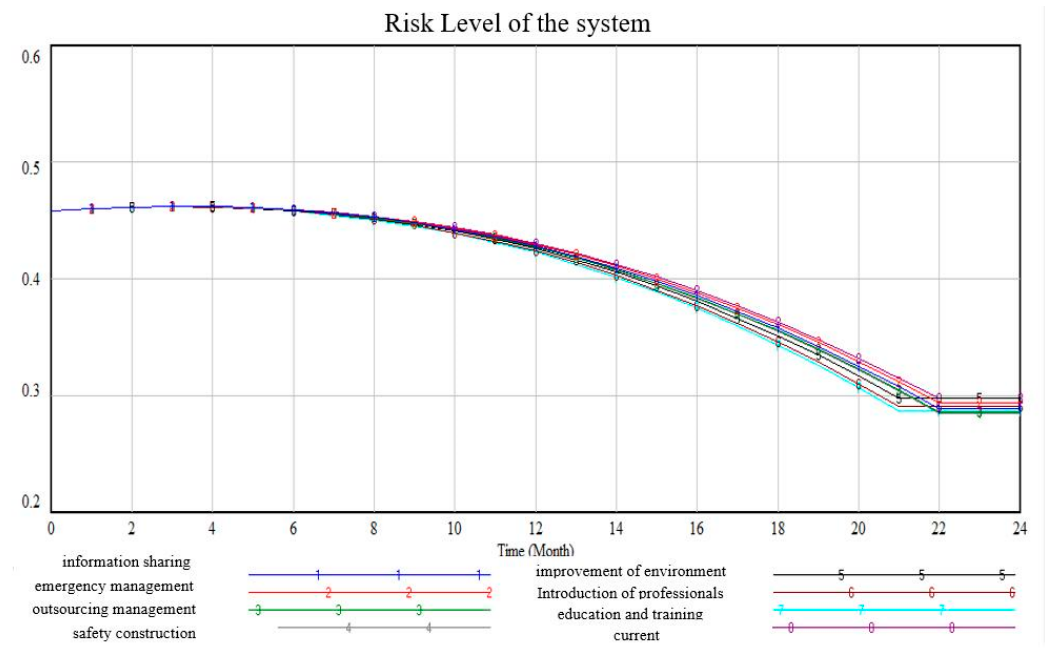
Figure 8. Contrast diagram of risk level under change of conversion rate.